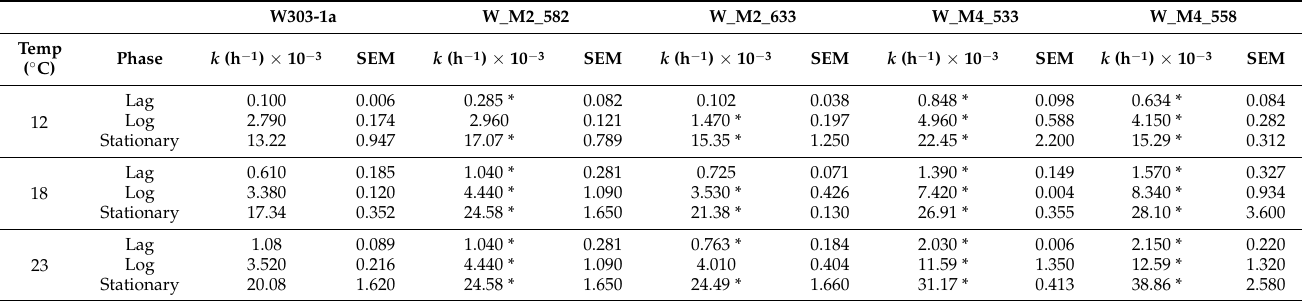
Table 5. Calculated fructose consumption reaction rate constants values ( k ) for each strain during fer- mentation phases at 12, 18 and 23 ◦ C. The * indicates the observed statistically significant differences between genetically modified strains and wild type ( p <